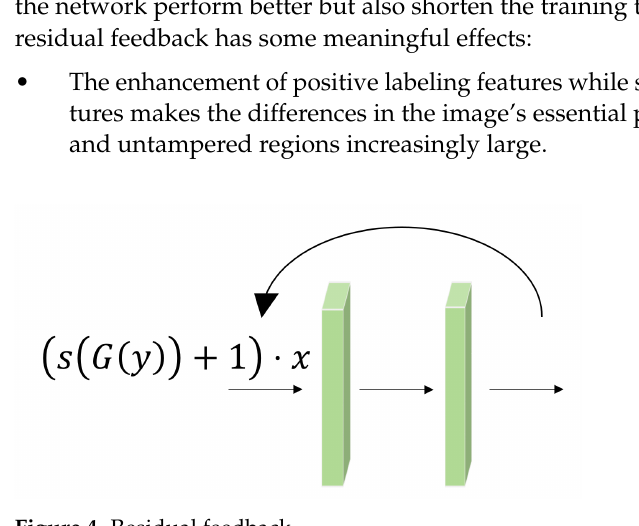
Figure 4. Residual feedback.